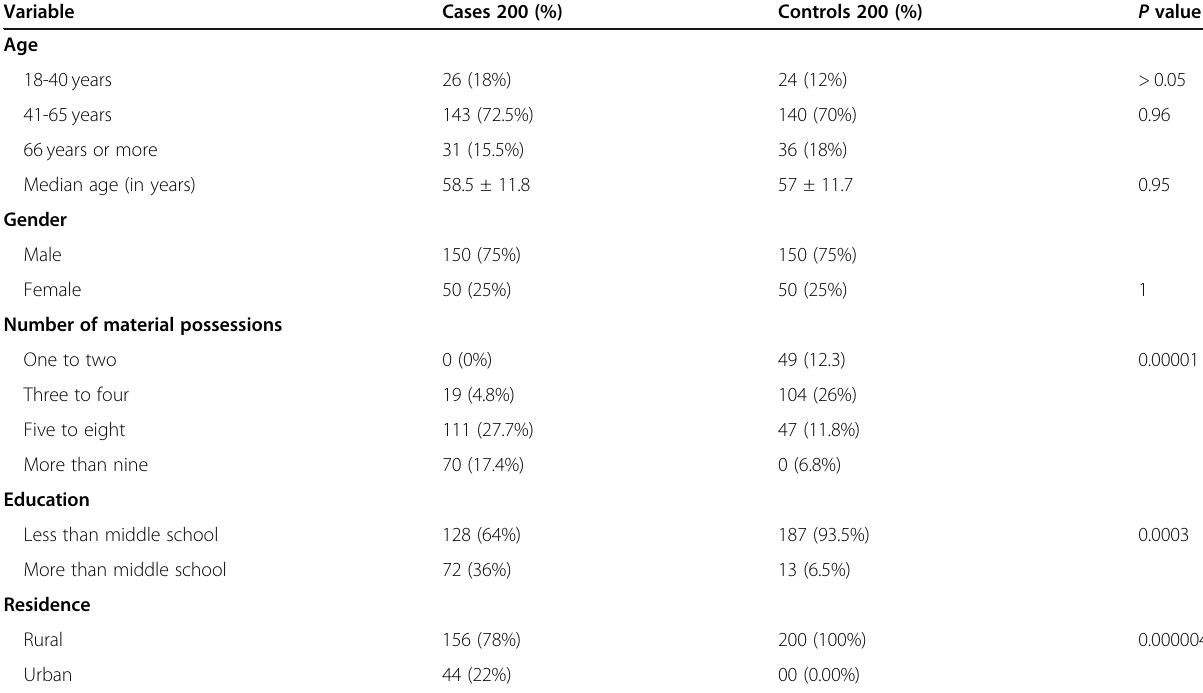
Table 1 Distribution of demographic and socio-economic variables among cases and controls ( n = 400)